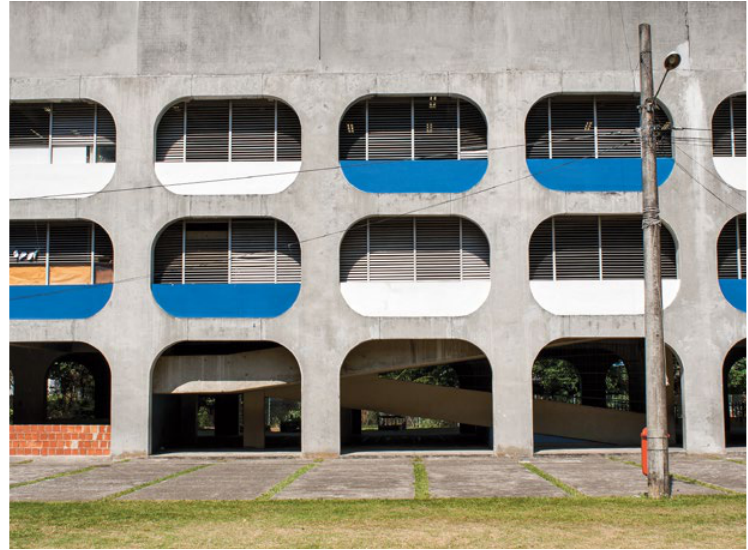
Figure 7 Detail of the main facade at CIEP Doutor Antoine Magarinos Torres Filho in Borel, showing Oscar Niemeyer’s disctinctive lozenge-shaped windows. Image © Aberrant Architecture.